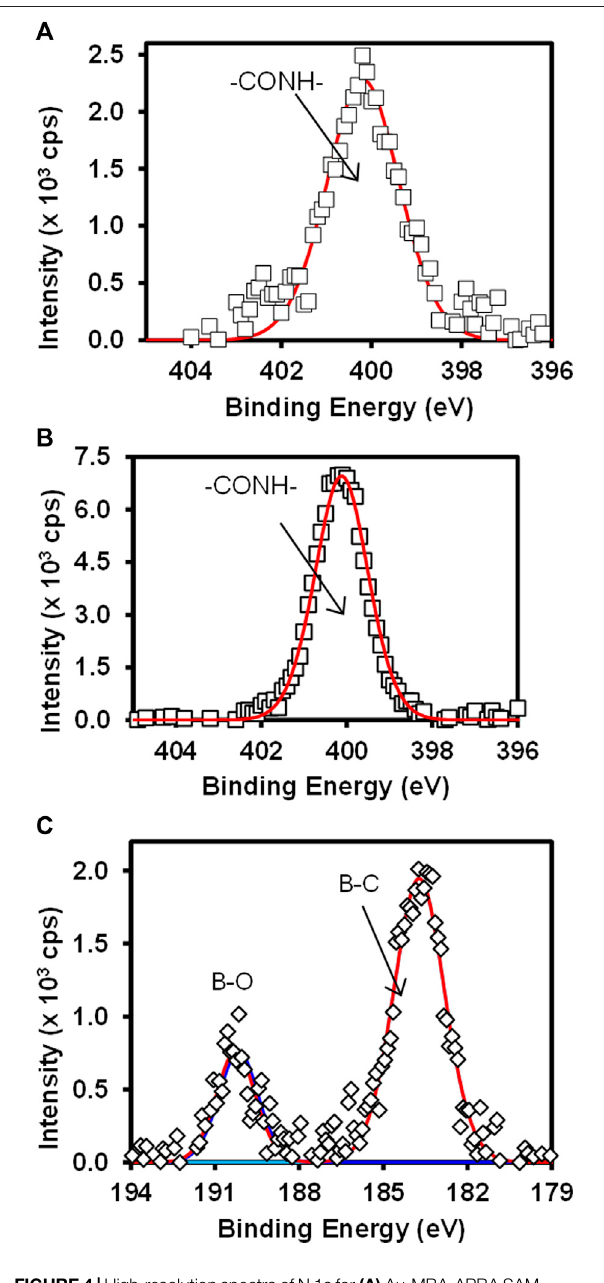
FIGURE 4 | High-resolution spectra of N 1s for (A) Au-MBA-APBA SAM and (B) Au-MBA-APBA-mAb/glucoseand (C) thehigh-resolutionspectrumof B 1s of Au-MBA-APBA